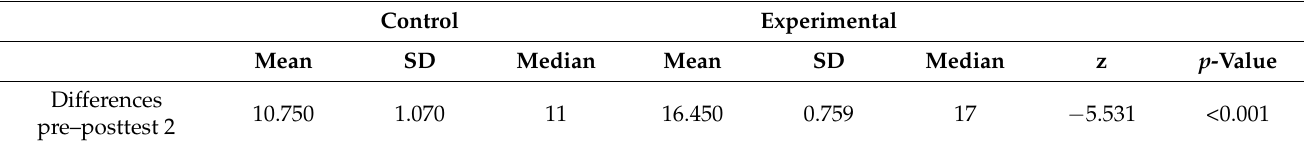
Table 15. Mann–Whitney U